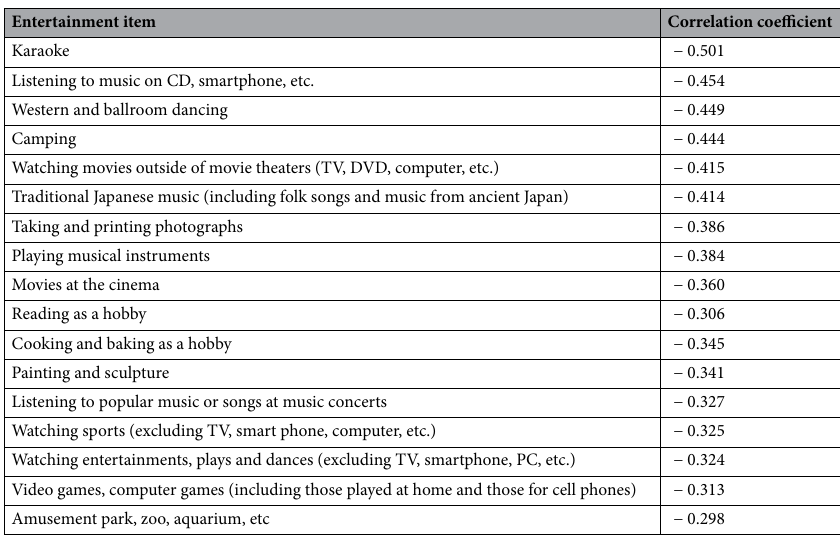
Table 6. Correlations between entertainment/hobby activities and SOGS scores (n =